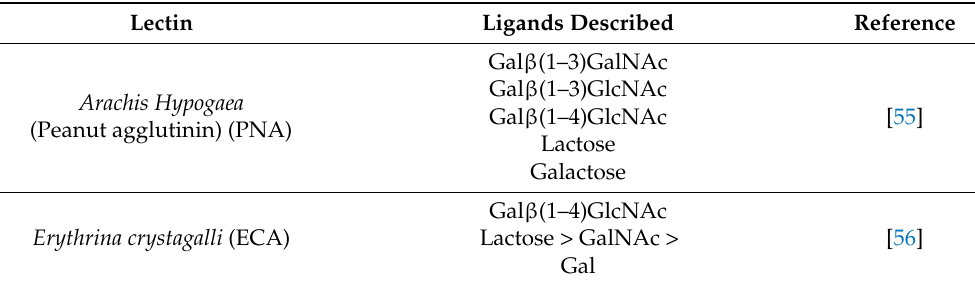
Table 1. Lectins used for characterization of carbohydrate structures present in Yops. Lectin Ligands Described Reference